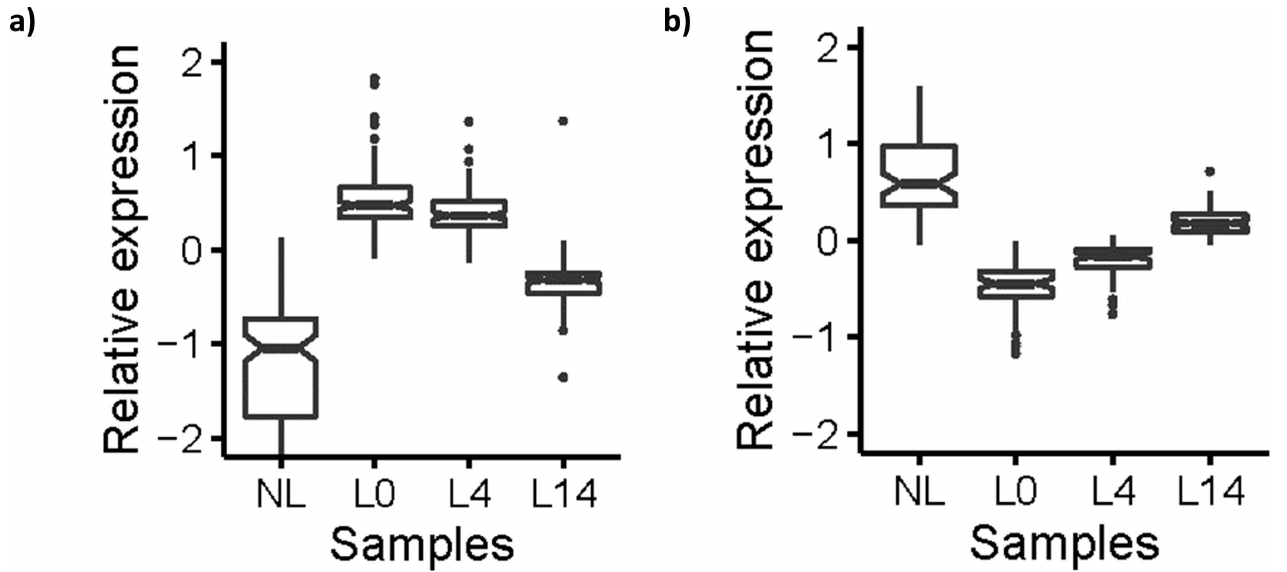
Fig 3. Relative expression of regulated genes in untreated lesional skin. (a) Upregulated and (b) downregulated genesin untreatedlesional psoriaticskin. Nonlesional skin (NL), lesionaluntreatedskin (L0), lesionalskin on day 4 after adalimumab treatment was initiated(L4) and lesional skin on day 14 after adalimumab treatment was initiated